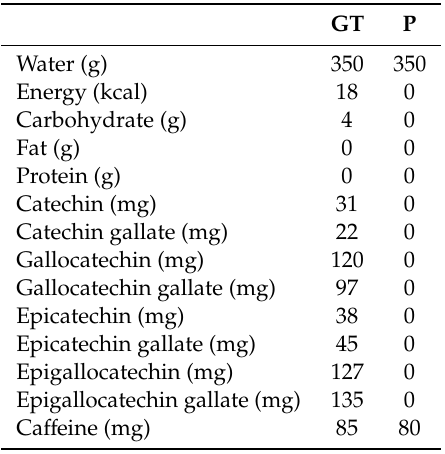
Table 1. Contents of catechin-rich green tea (GT) and placebo beverage (P).